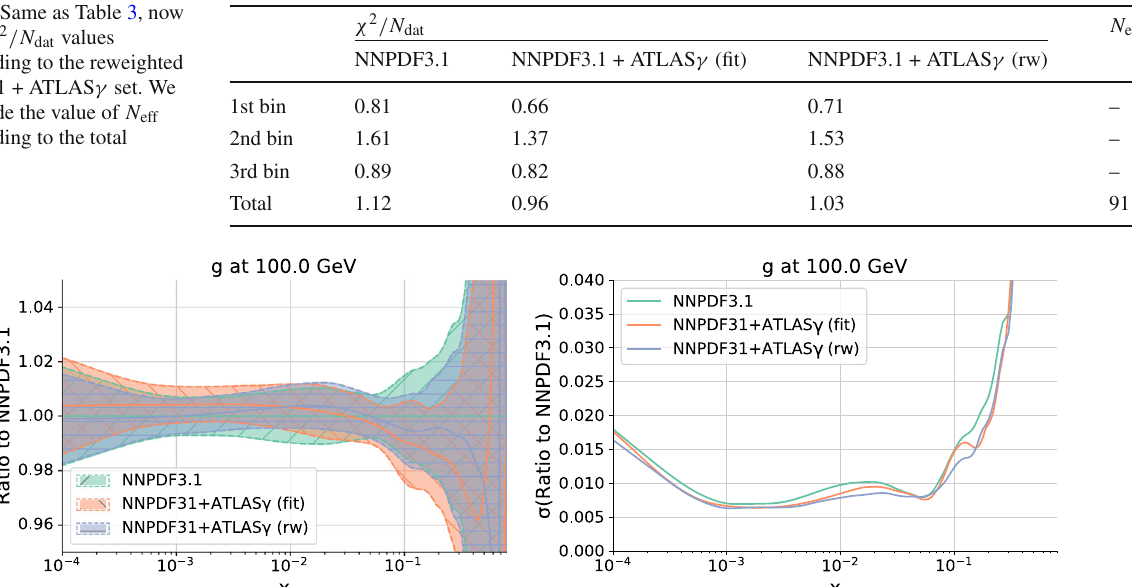
Fig. 14 Same as Fig. 6 now adding to the comparison the results of the NNPDF3.1 + ATLAS γ (rw) set obtained by applying the Bayesian reweighting